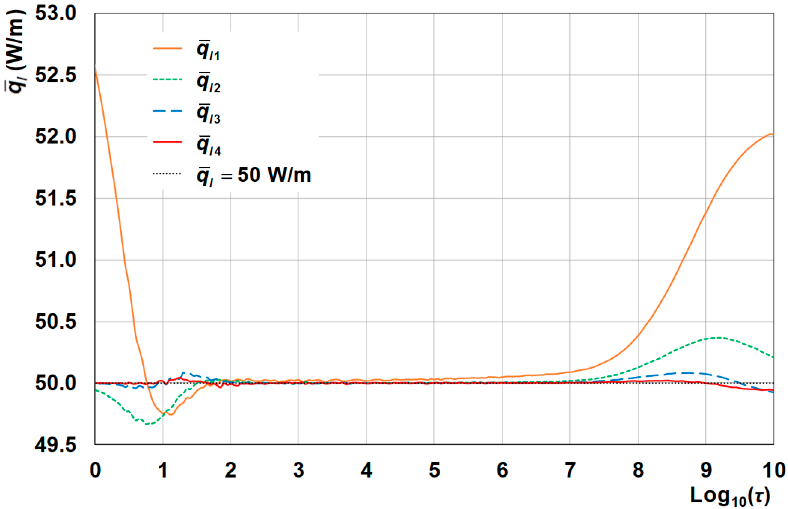
Figure 8. Plots of l q versus log 10 ( τ ), for the fluid-to-ground thermal responses θ f 1 , θ f 2 , θ f 3 , θ f 4 , OMEC model.